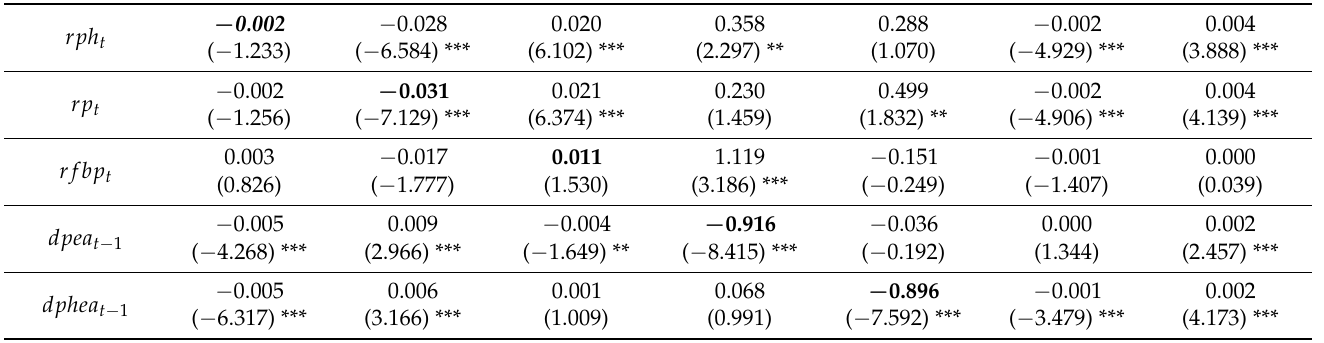
Table 2. The combined effects Π